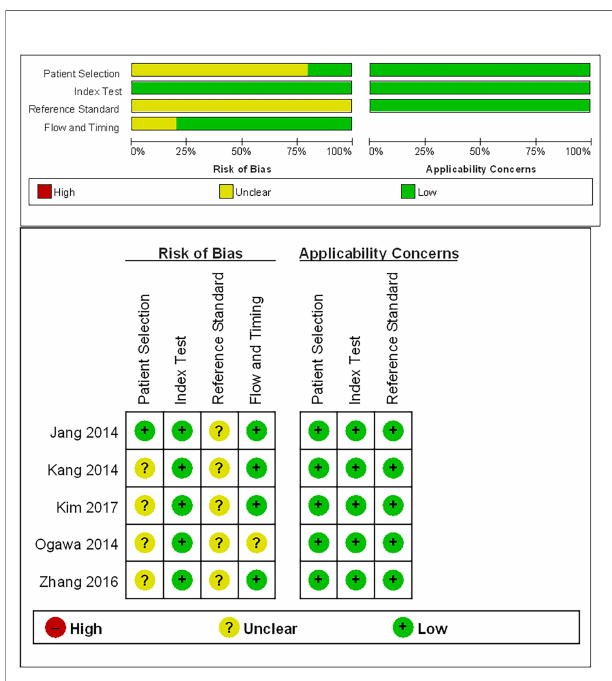
FIGURE 2 | Quality Assessment of Diagnostic Accuracy Studies-2 (QUADAS-2) criteria for the fi ve included studies.